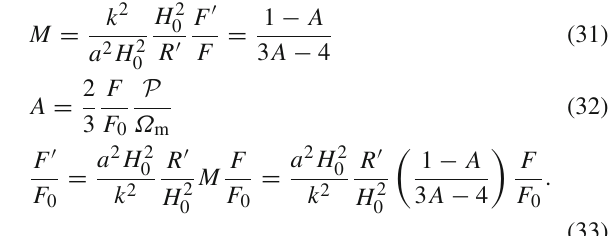
Table 1 The lower bounds of Compton wavelength of massive graviton, λ g and its corresponding upper bounds of the graviton mass, m g = h /(λ g c ) from different observations λ 2 ) Obs Properties g (km) m g (eV/ c